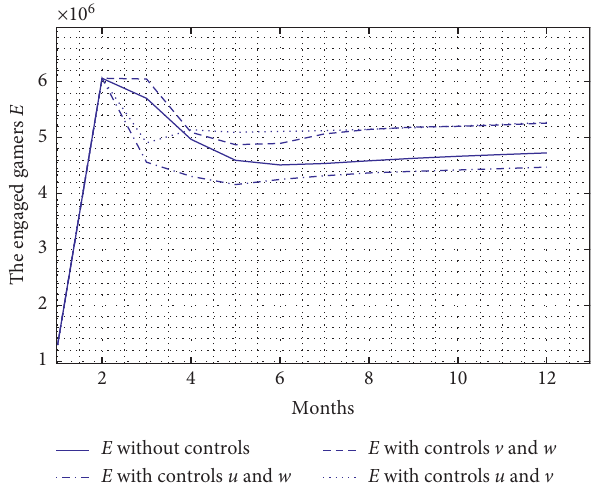
Figure 7: Development of the number of the engaged gamers with the combination of two controls among the controls u k , v k , and w k .